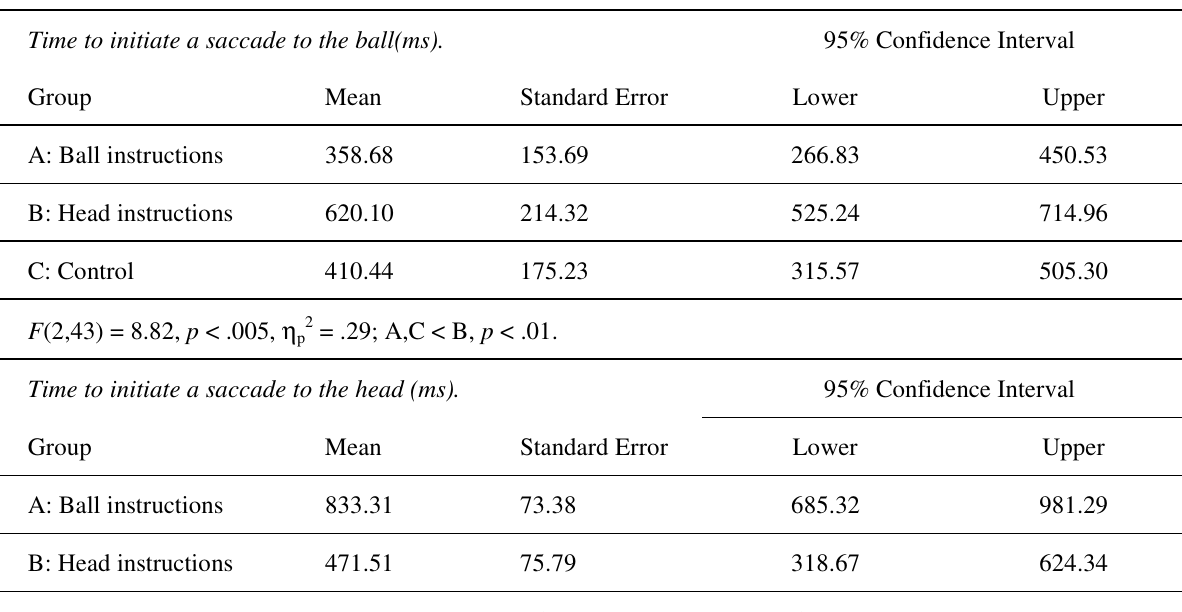
Eye movement data summary, by